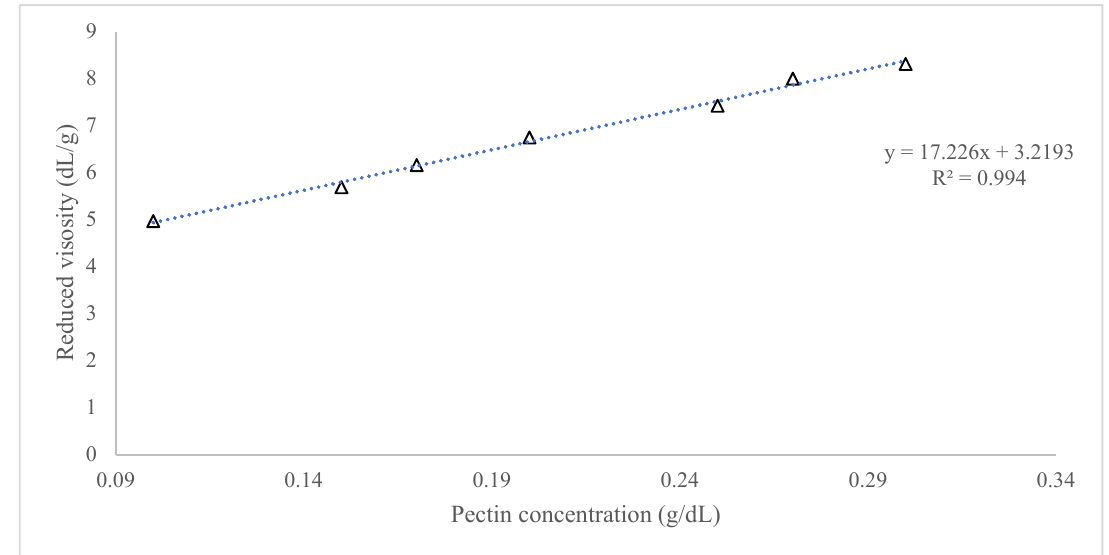
Figure A2. Reduced viscosity curve of Haden mango peel pectin.